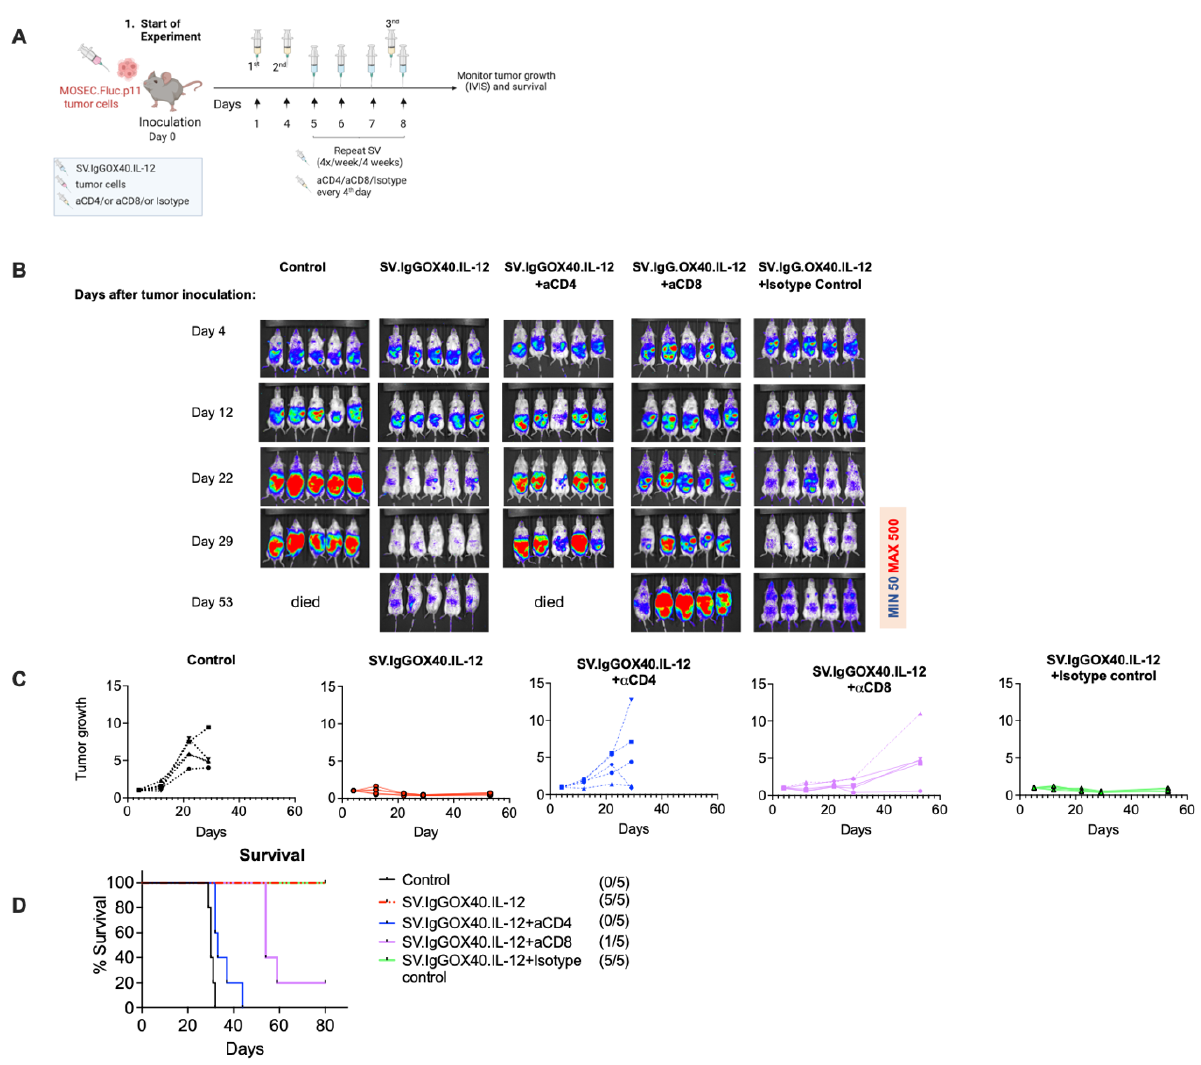
Figure 6. Therapeutic efficacy of SV.IgGOX40.IL-12 is dependent on CD4 and CD8 T cells. ( A ) Experimental set-up and injections. Tumors were inoculated on day 0 and SV.IgGOX40.IL-12 treatment began on day 5. Mice were injected with α CD4 (0.5 mg) or α CD8 (0.1 mg)-depleting antibody. As control, rat IgG2b (0.5 mg) isotype control was used, starting on day 1 and 4 after tumor inoculation and every 4th day for a total of 4 weeks. C57BL/6 albino mice were inoculated with 2.5 × 10 6 MOSEC.p11.Fluc tumor cells on day 0. Mice were left untreated or were treated with SV.IgGOX40.IL-12 four days per week. ( B ) Representative bioluminescence images of control and treated tumor-bearing mice groups. ( C ) MOSEC.Fluc.p11 tumor growth curves shown as bioluminescence (RLU day X/RLU first day) total counts over time for each individual mouse. ( D ) Survival plots.